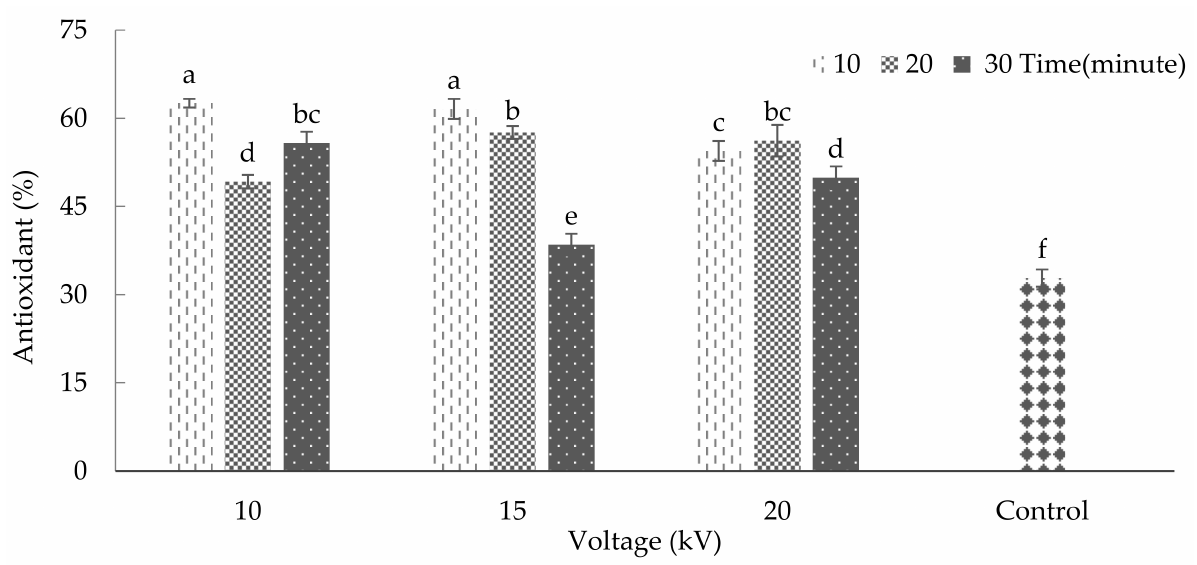
Figure 7. Plasma effect on antioxidant activity of basil. Error bars indicate standard error ( n = 3). Different lowercase letters denote statistical differences between treatment groups at the 5% level according to Duncan’s